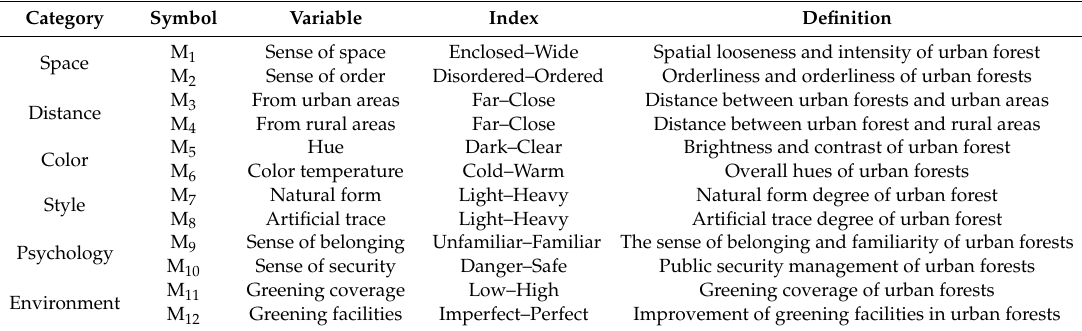
Table 2. Scale on SD semantic di ff erences for spatial image perception of urban forests in Beijing.